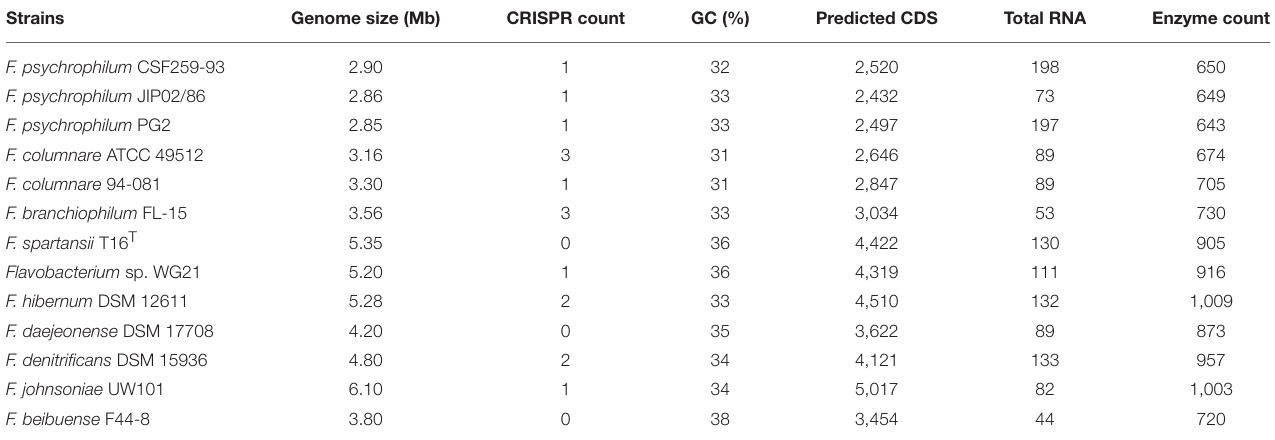
TABLE 1 | The genome features of the selected Flavobacterium spp.